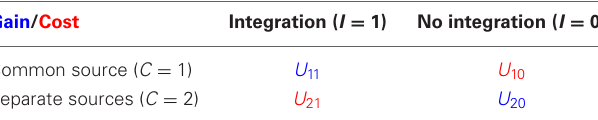
Table 1 | Payoff matrix for the basic decision